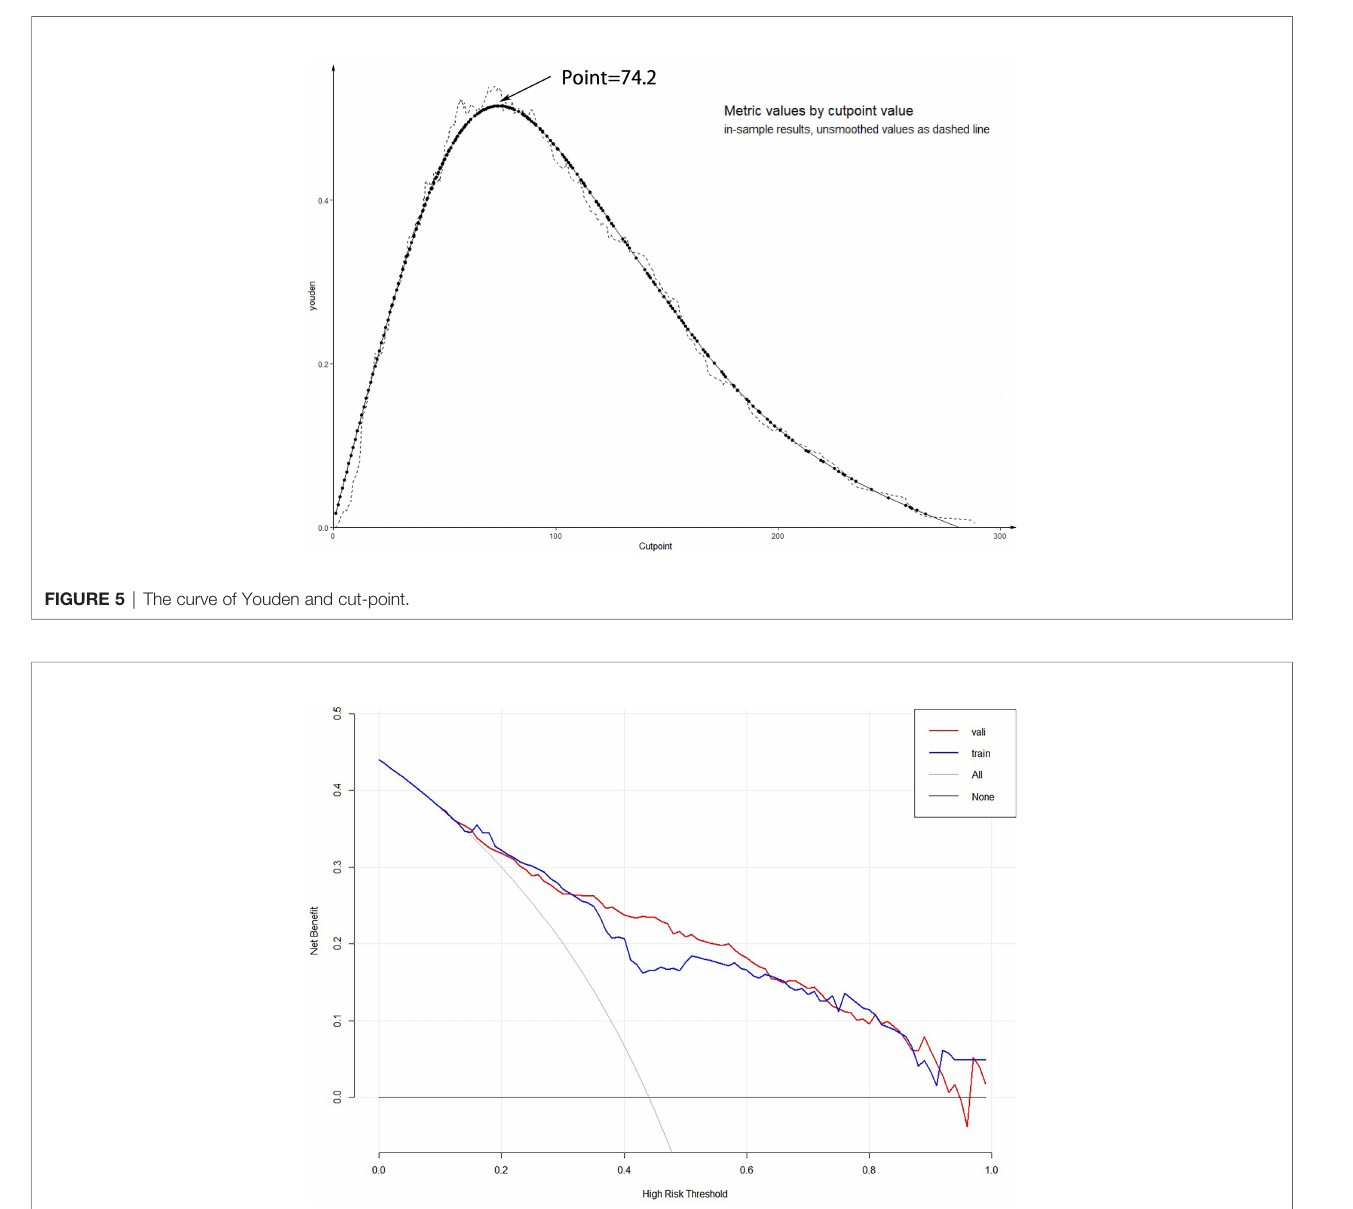
FIGURE 6 | Decision curve analysis for LLNM in MTC